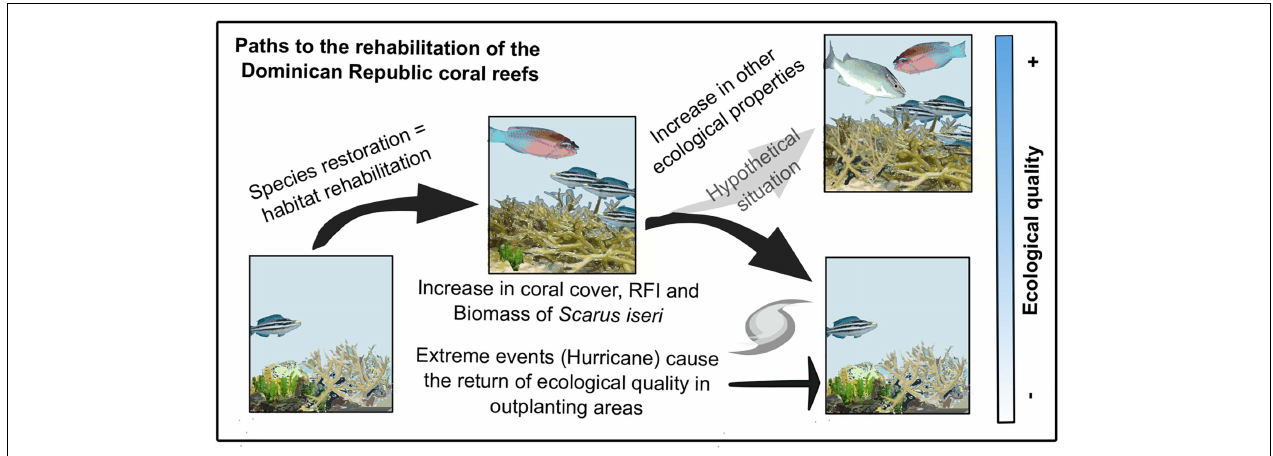
FIGURE 5 | Conceptual model. Species restoration induces habitat rehabilitation, increasing coral cover, RFI, and biomass in this particular case study of Scarus iseri . Damage from storms or hurricanes would be even greater if no active restoration efforts were undertaken. Continued active restoration efforts will improve the ecological health of coral